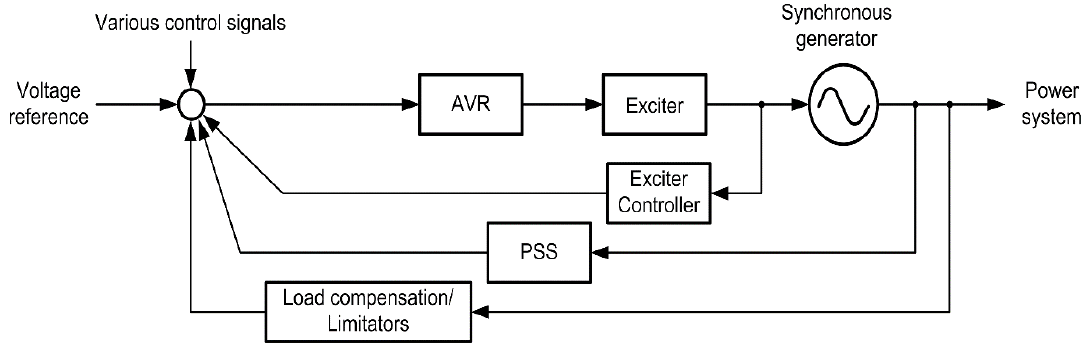
Figure 1. Synchronous generator excitation system.